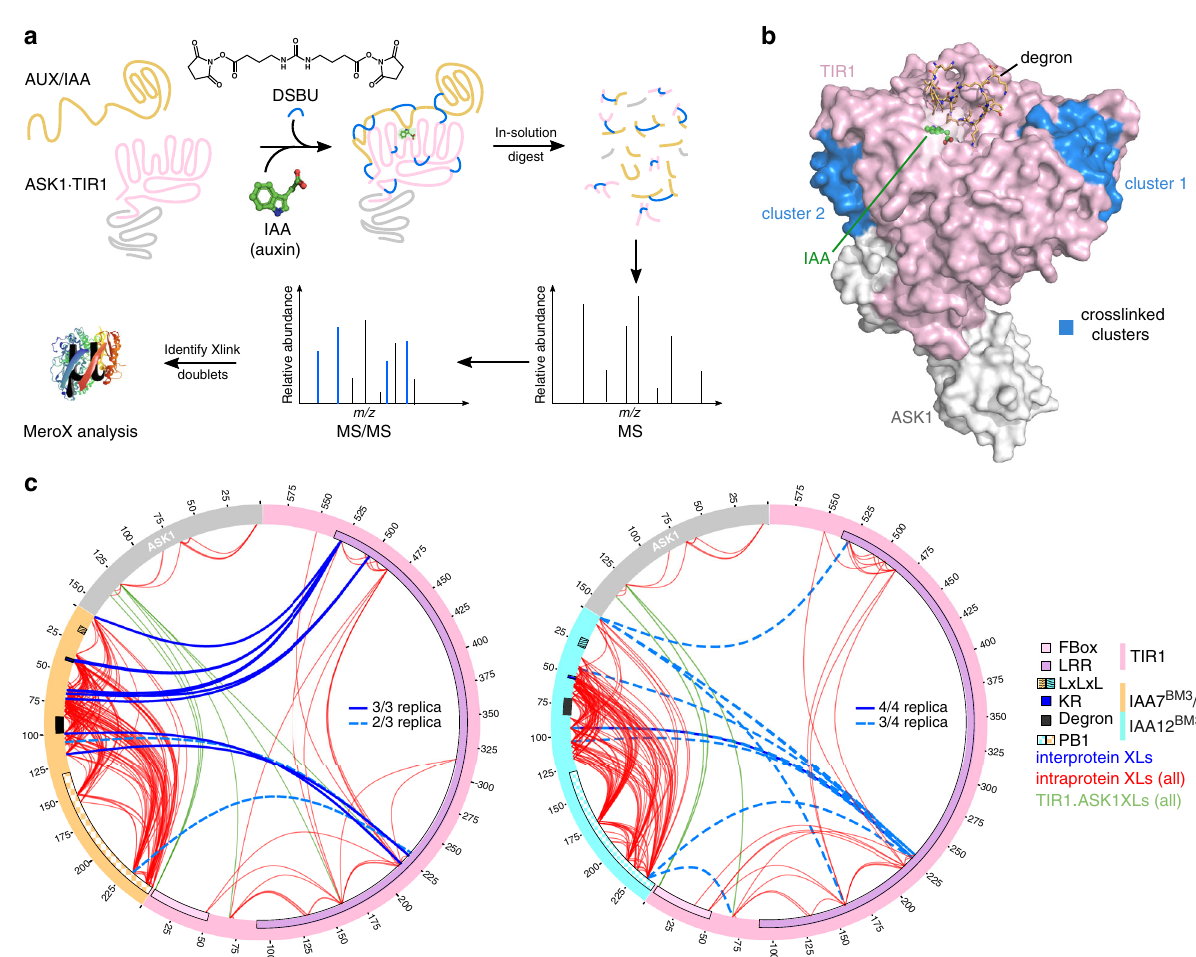
Fig. 4 Structural proteomics using an MS-cleavable crosslinker reveals TIR1·IAA7 and TIR1·IAA12 interaction interfaces. a Work fl ow for the cross- linking coupled to mass spectrometry (XL-MS) approach. Recombinant oligomerization-de fi cient IAA7 (orange) and IAA12 (aquamarine) proteins, and ASK1·TIR1 (gray and light pink, respectively) were incubated with the DSBU crosslinker, and samples were analyzed using LC/MS 2 . Crosslinked peptides were identi fi ed using the MeroX software. b Interaction interfaces (blue) on TIR1 converge in two distinct patches around LRR4 – 7 (cluster 1) or LRR17 – 18 (cluster 2) revealing AUX/IAAs adopt an extended fold when in complex with TIR1. c Circular depiction of inter-protein (TIR1·AUX/IAAs) (blue) and intra- protein (red) crosslinks (XLs) along IAA7 (orange), IAA12 (aquamarine), TIR1 (light pink) and ASK1 (gray) protein sequence. XLs were identi fi ed in at least 2/3 or 3/4 independent experiments (dashed: 2/3 and 3/4; solid lines: 3/3 and 4/4). Speci fi c XLs within TIR1 and between TIR1 and ASK1 (green) are in agreement with the crystal structure (PDB: 2P1Q [http://www.rcsb.org/structure/2P1Q]). Known motifs and protein domains are